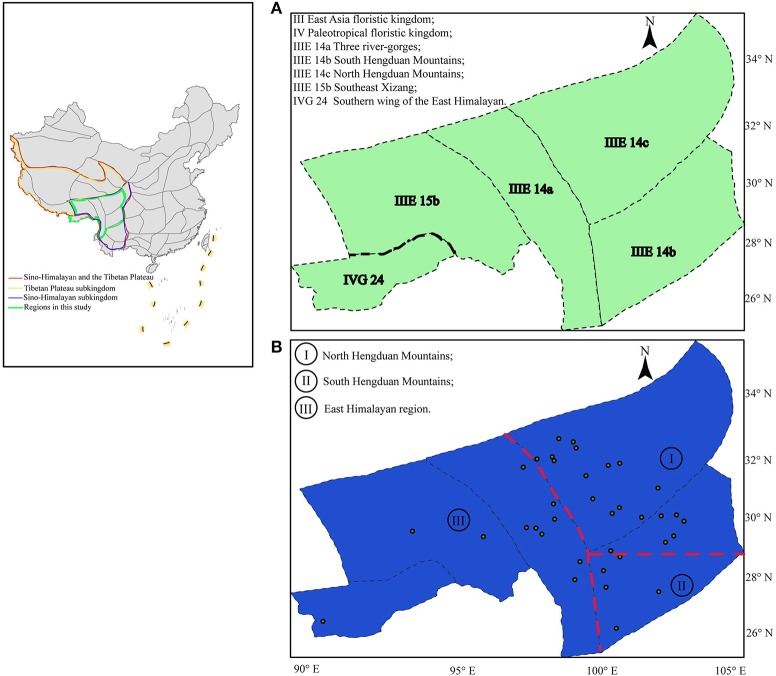
Biogeographic regions proposed for the flora of the QTP-HDM: (A) Previous regions proposed and modified from Wu and Wu (1996); (B) Simplified phylogeoregions proposed in this study based on private haplotypes: phylogeoregions I, II, and III represent the north and south Hengduan Mountains phylogeoregions, and the Eastern Himalayan phylogeoregion, respectively. The dots in (B) correspond to the 36 natural populations of Parasyncalathium souliei in this study.